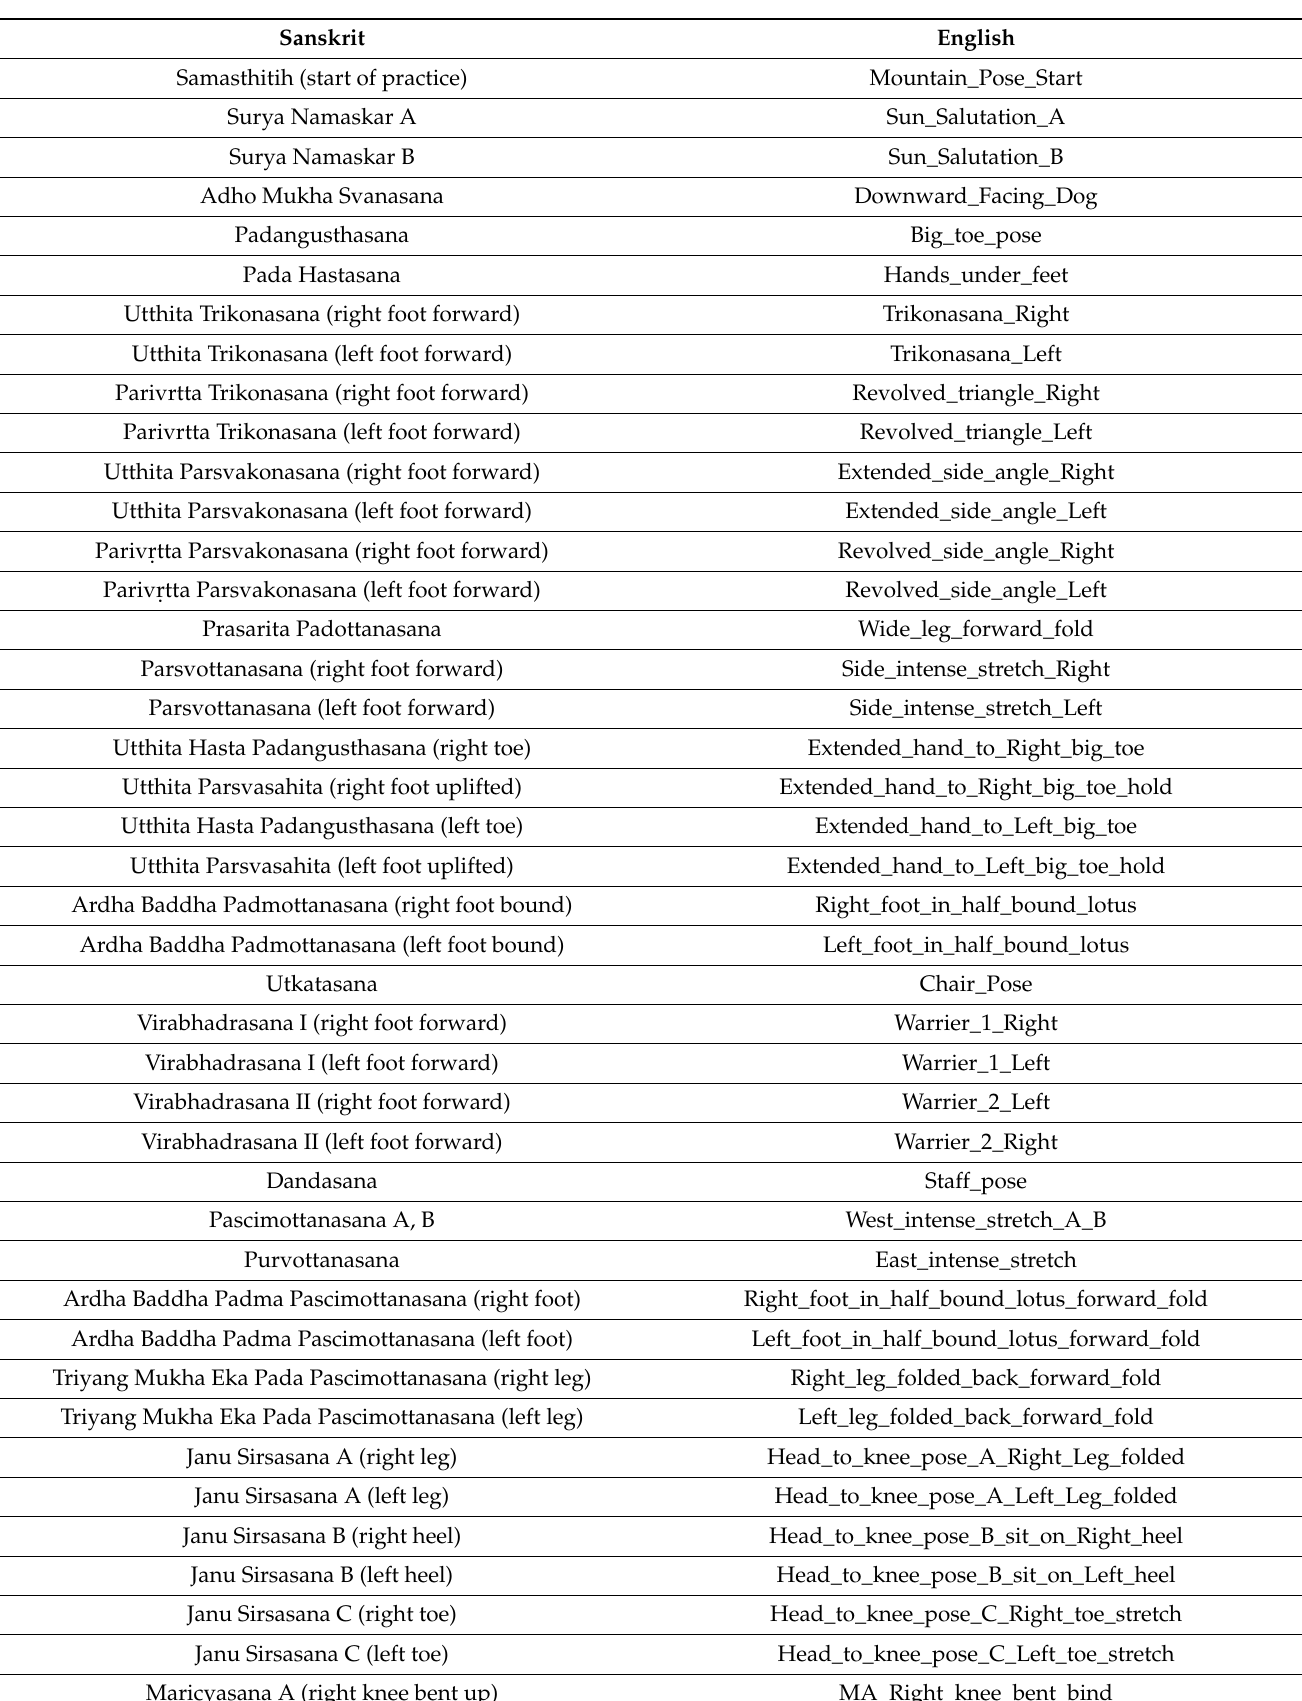
Table A2. Video coded postures/list of postures used in the